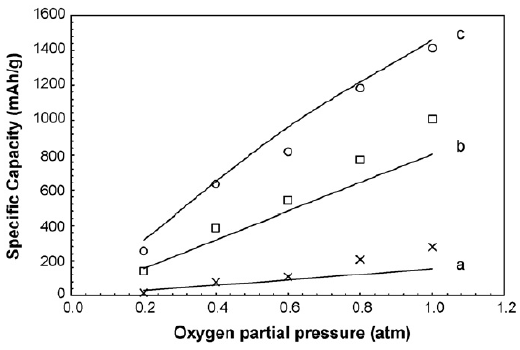
Figure 3. Specific capacities as a function of oxygen partial pressure for current densities of ( a ) 0.5; ( b ) 0.1; and ( c ) 0.05 mA/cm. Symbols are experimental values. Reprinted from Sandhu et al. [15], with permission from Elsevier.